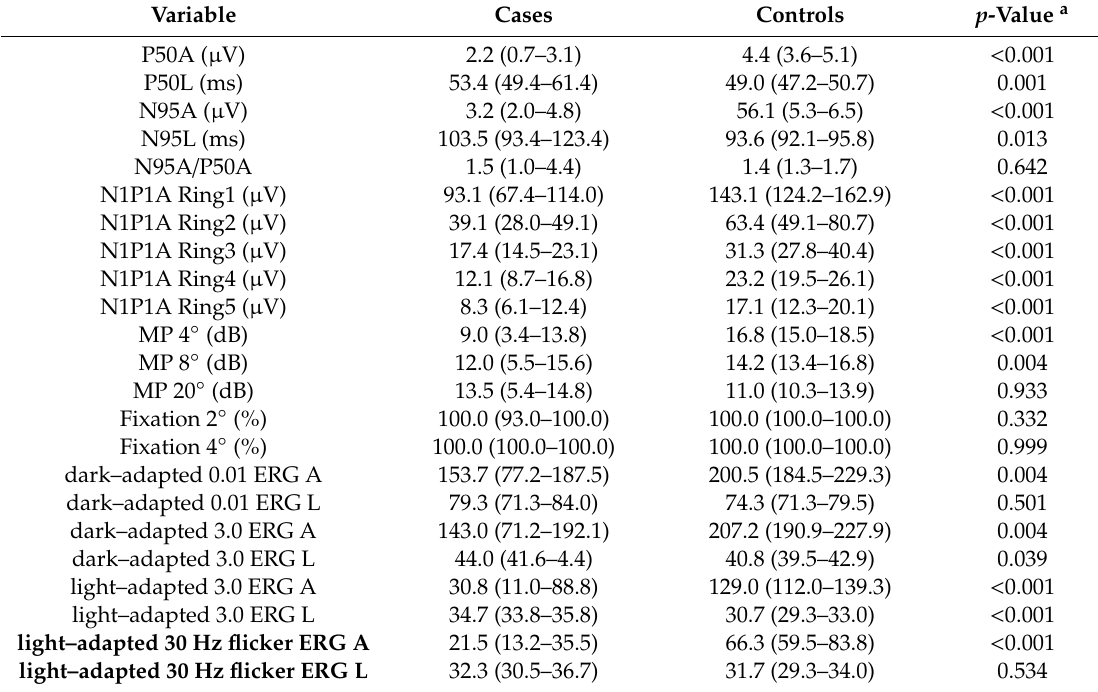
Table 2. Functional parameters of cases and controls expressed as median and interquartile